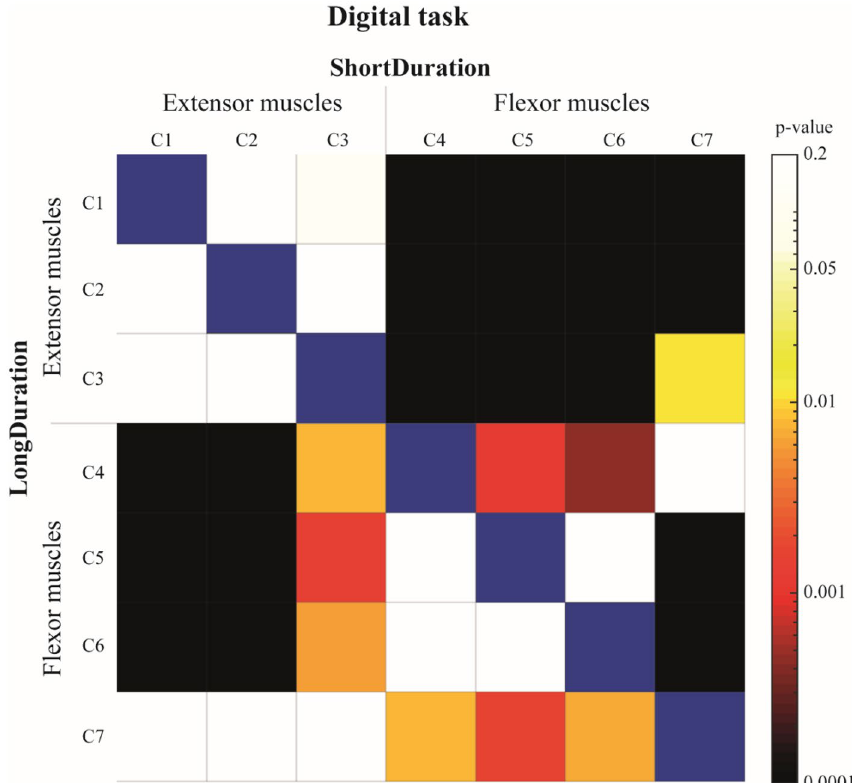
Figure 4. Colormap representation of p values of the Tukey post-hoc analysis for the columns’ comparison of the Digital task. Results of the ShortDuration group are represented above the blue diagonal while results of the LongDuration group are represented below the blue diagonal (α = 0.05). For example, the variation of EMG median frequency (I 5 –I 0 ) of c1 for the ShortDuration group (first row, first column) is not significantly different from c2 (first row, second column), but is significantly different from c4 (first row, fourth column). Similarly, the variation of EMG median frequency (I 5 –I 0 ) of c1 for the LongDuration group (first column, first row) is not significantly different from c2 (first column, second row), but is significantly different from c4 (first column, fourth